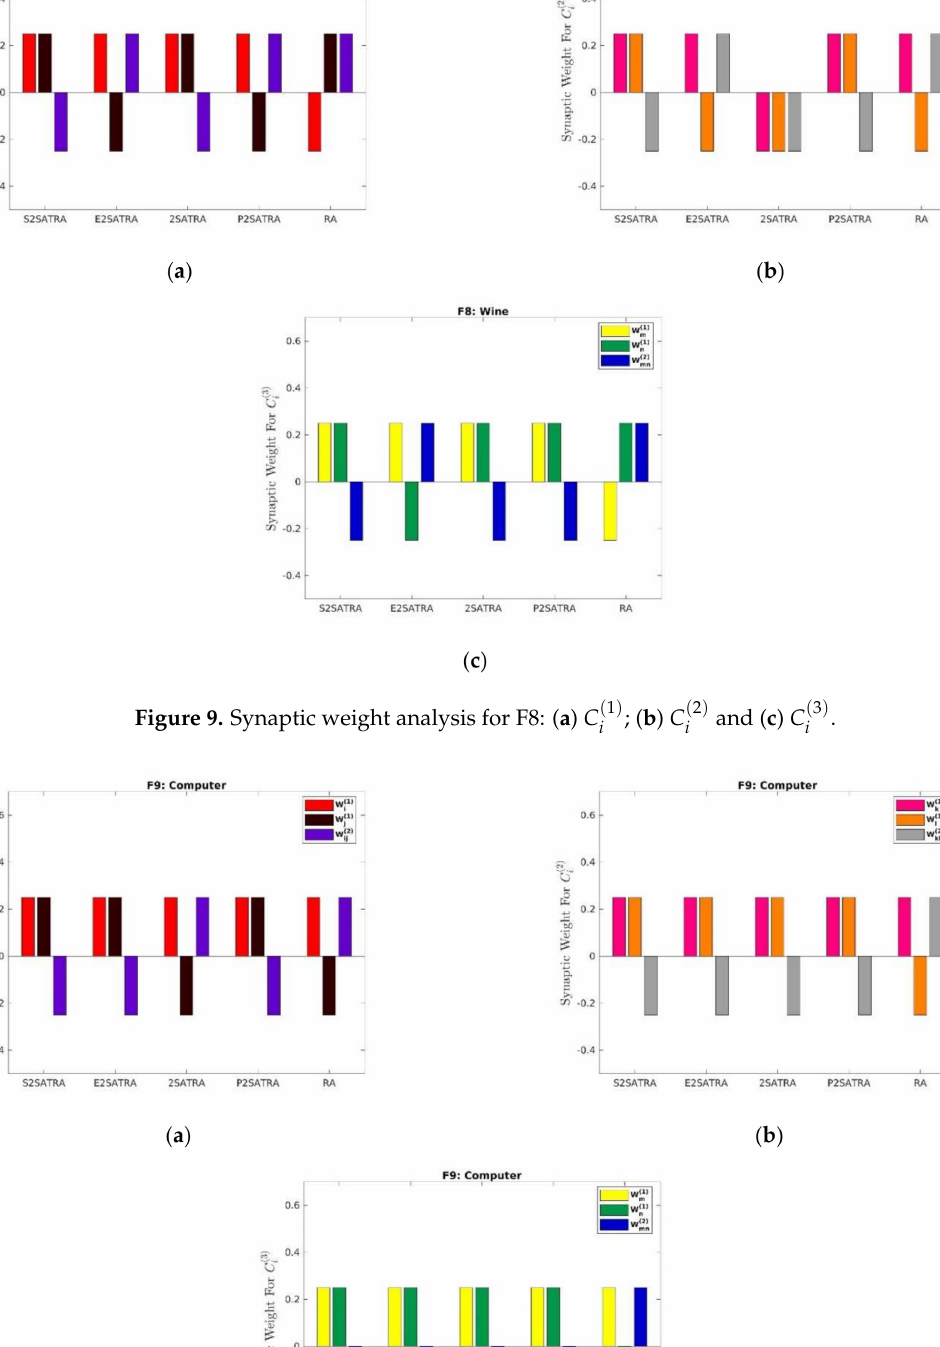
( 1 ) ( 2 ) ; ( b ) C and ( c ) C i i